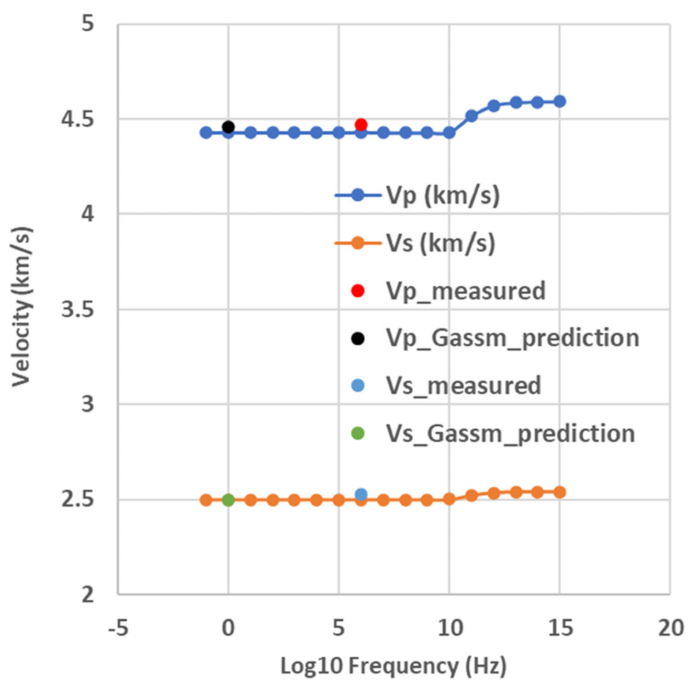
Figure 7. Plot of the squirt-flow P-wave (blue line) and S-wave (orange line) velocity predictions with log frequency. The low-frequency limit P-wave velocity Gassmann prediction is the black data point. The red data point is the measured P-wave velocity at ultrasonic frequency on the fully brine-saturated sample. The blue discrete data point is the measured S-wave velocity on the fully brine-saturated sample, which agrees well with the squirt-flow predicted value. The low-frequency limit S-wave velocity Gassmann prediction is the green data